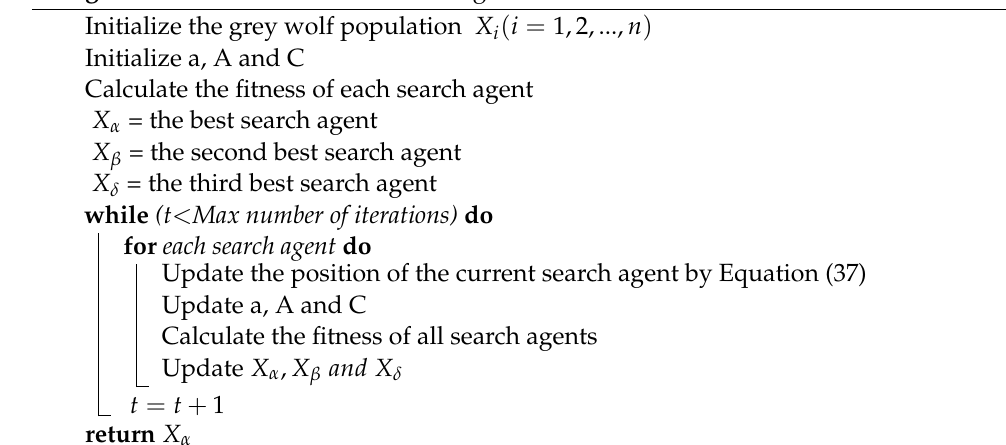
Algorithm 3: Pseudo-code of GWO algorithm.